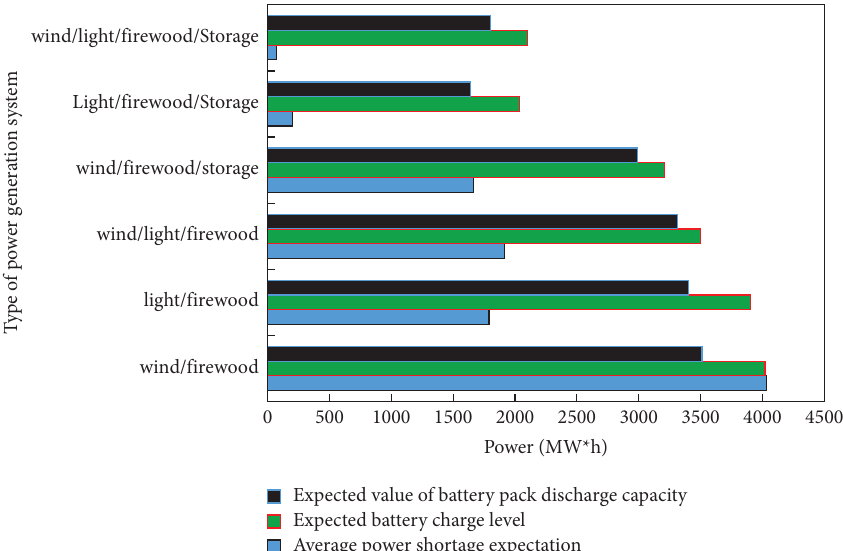
Figure 8: Reliability metrics for diferent system basic